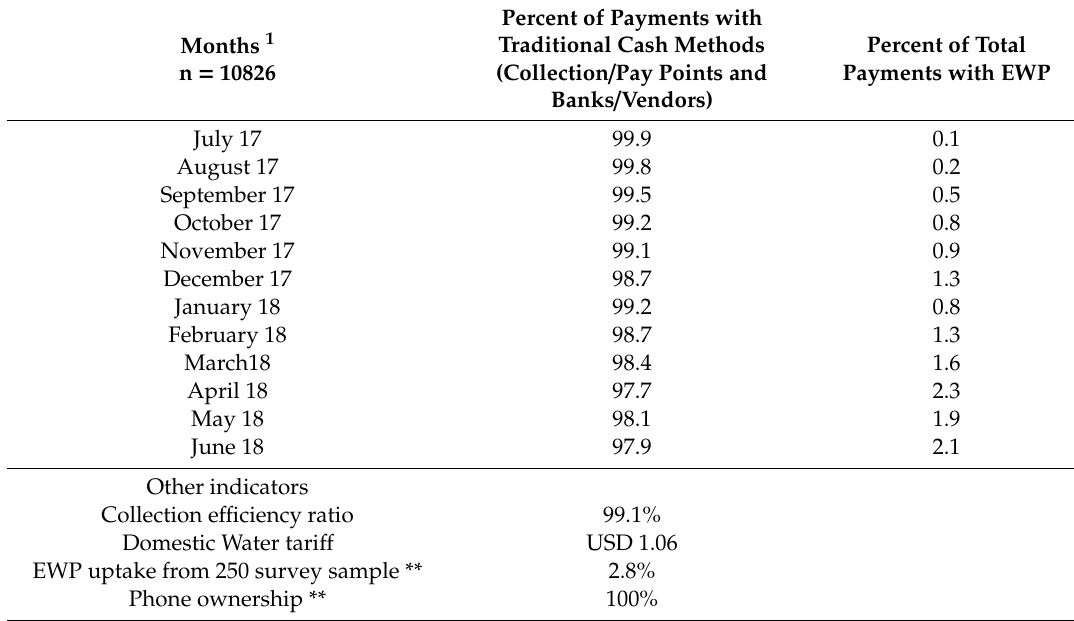
Table 3. Proportion of customer payment preferences from July 2017 to June 2018 in Tema Central District from GWCL payment